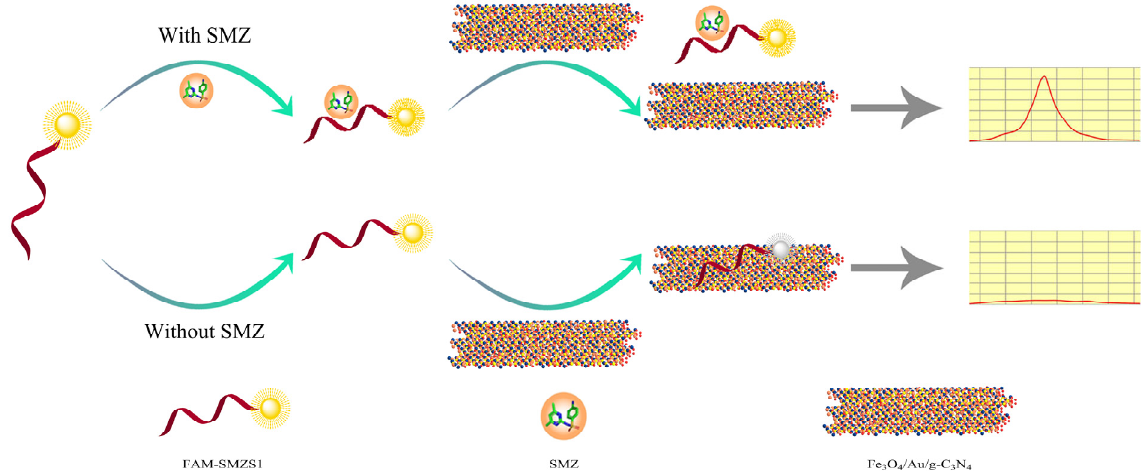
Figure 2. The principle of the aptasensor for SMZ detection.